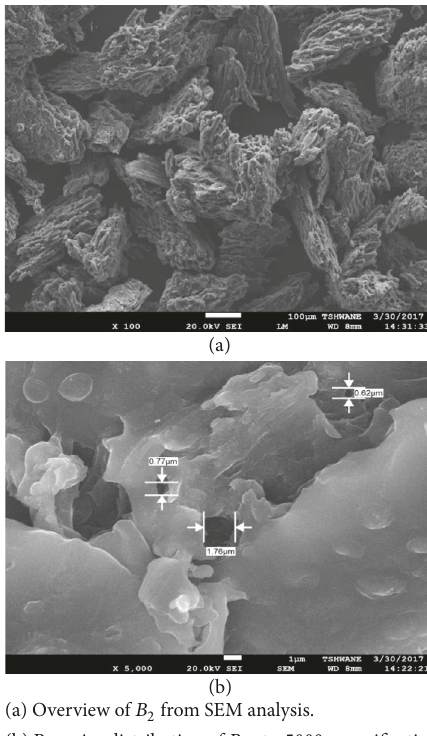
(b) B 2 from SEM analysis. (a) Overview of (b) Pore size distribution of B 2 at ×5000 magnification.